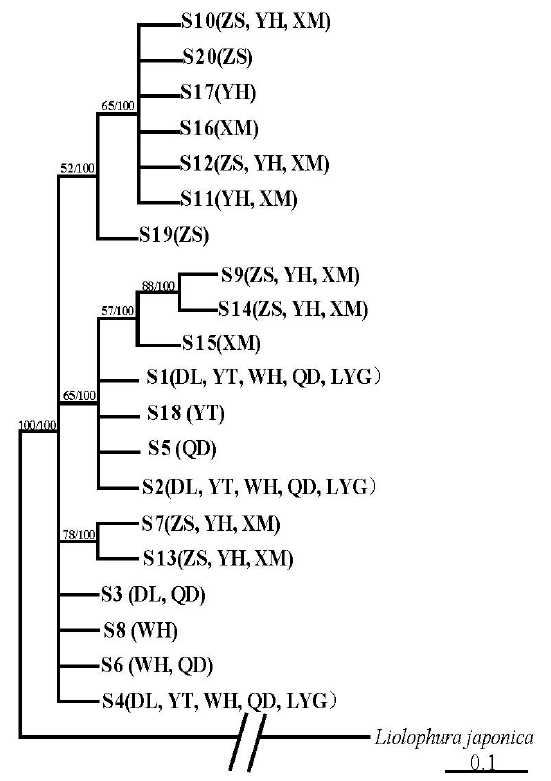
Figure 4. Bayesian tree based on 28S-rRNA sequences of A. rubrolineatus. The posterior probability values were showed.